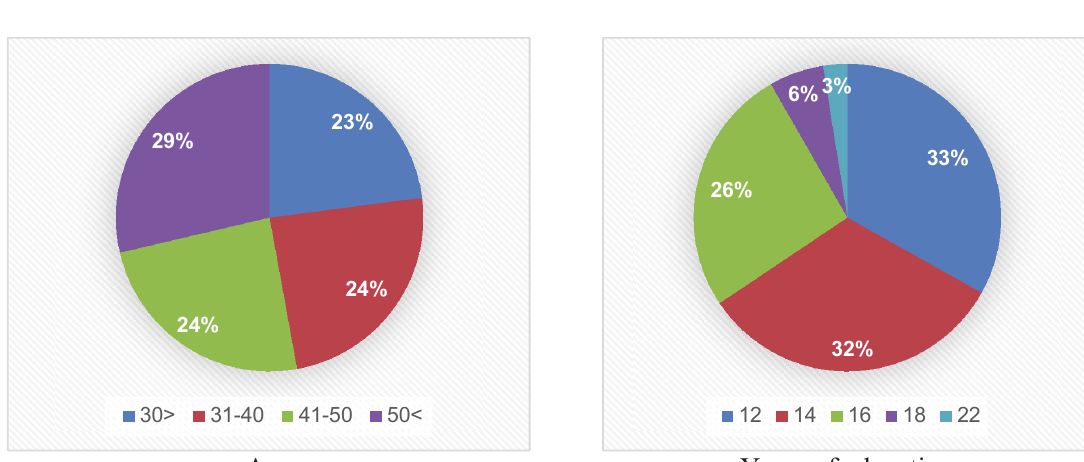
Fig. 2. Personal characteristics of the participants